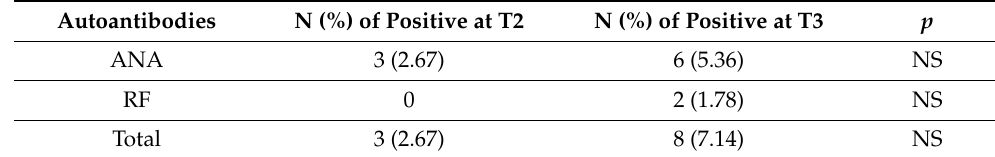
tional booster of the specific vaccine between T2 and T3. The GMCs at three time points (T0 = pre-vaccination, T2 = 9-month post-vaccination, T3 = 5-year post-vaccination) of the